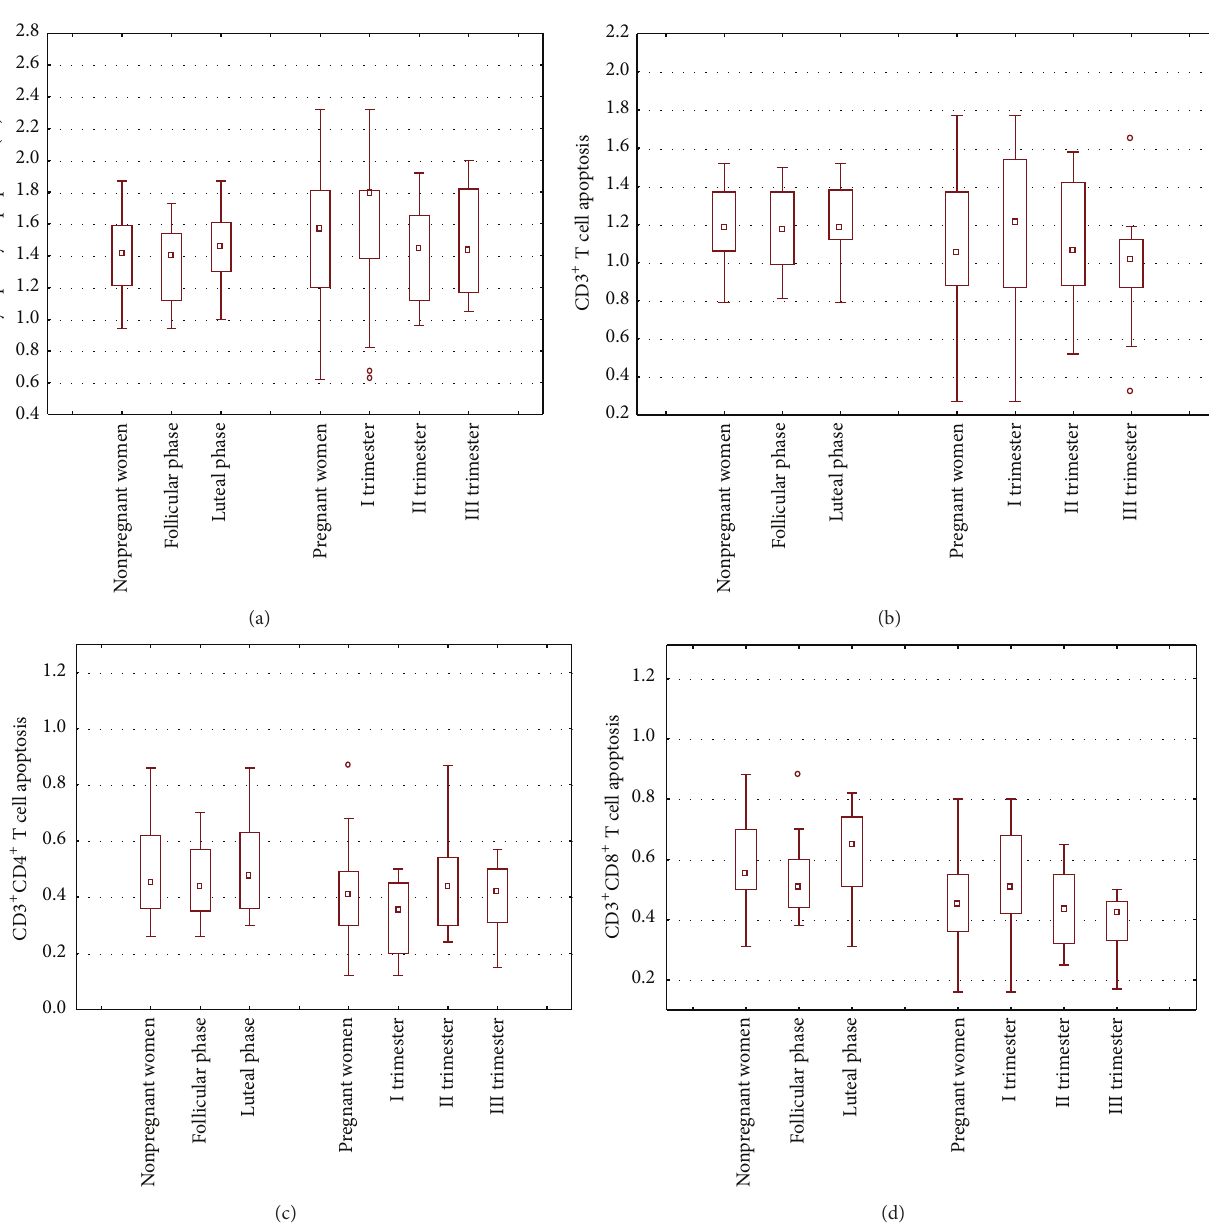
in T lymphocyte apoptosis [22,